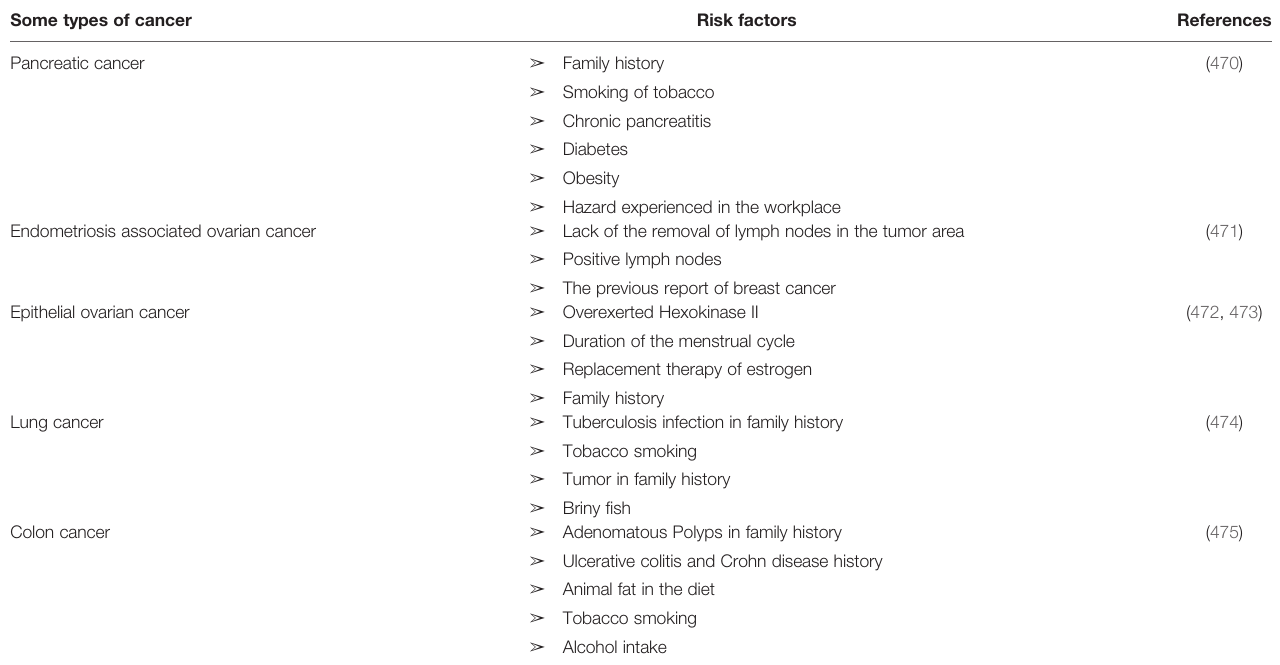
TABLE 4 | Risk factors of drug resistance in cancer